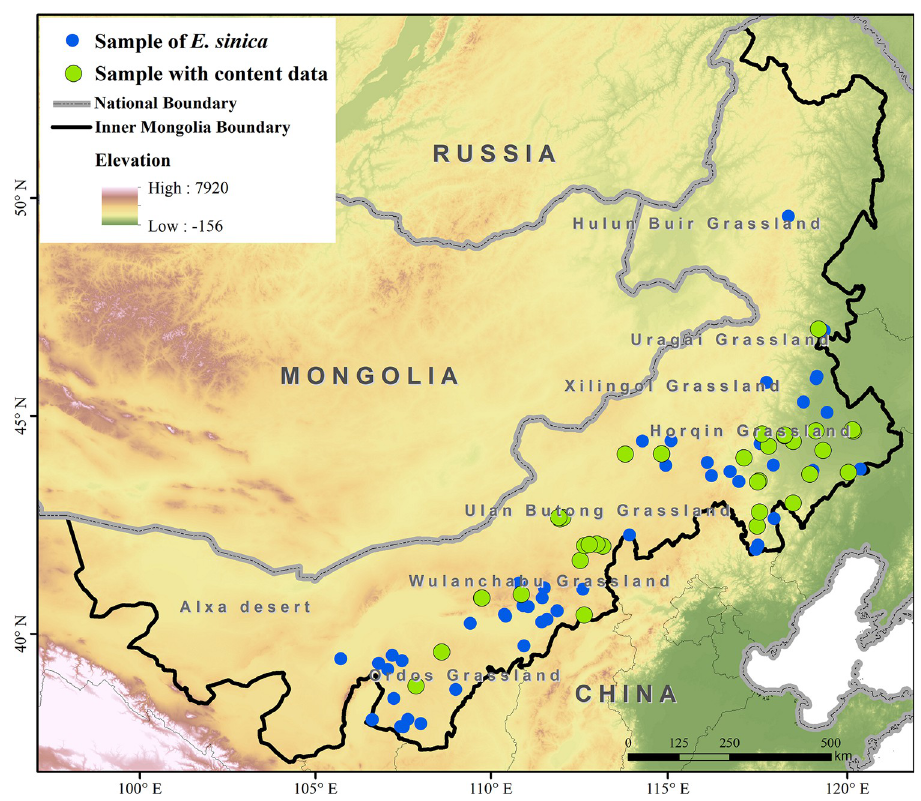
Fig 1. Study area and sampling site distribution. The boundary was obtained from Natural Earth (http://www. naturalearthdata.com) and was further processed using ArcGIS version 10.3 software.